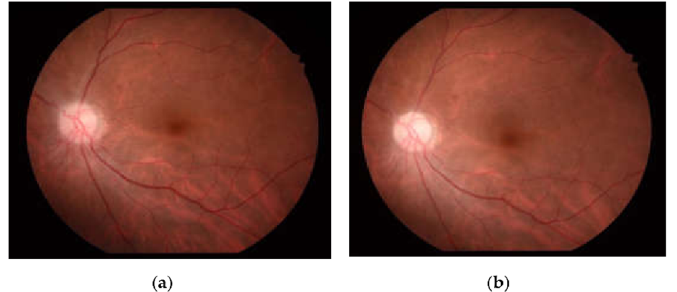
Figure 1. Fundus photography of the left eye ( a ) on initial examination showed pinkish optic disc with optic disc edema (Frisen scale grade 2), and ( b ) after treatment with oral prednisolone, the optic disc edema resolved, and the optic disc became pale with a gliotic appearance in the temporal margin.